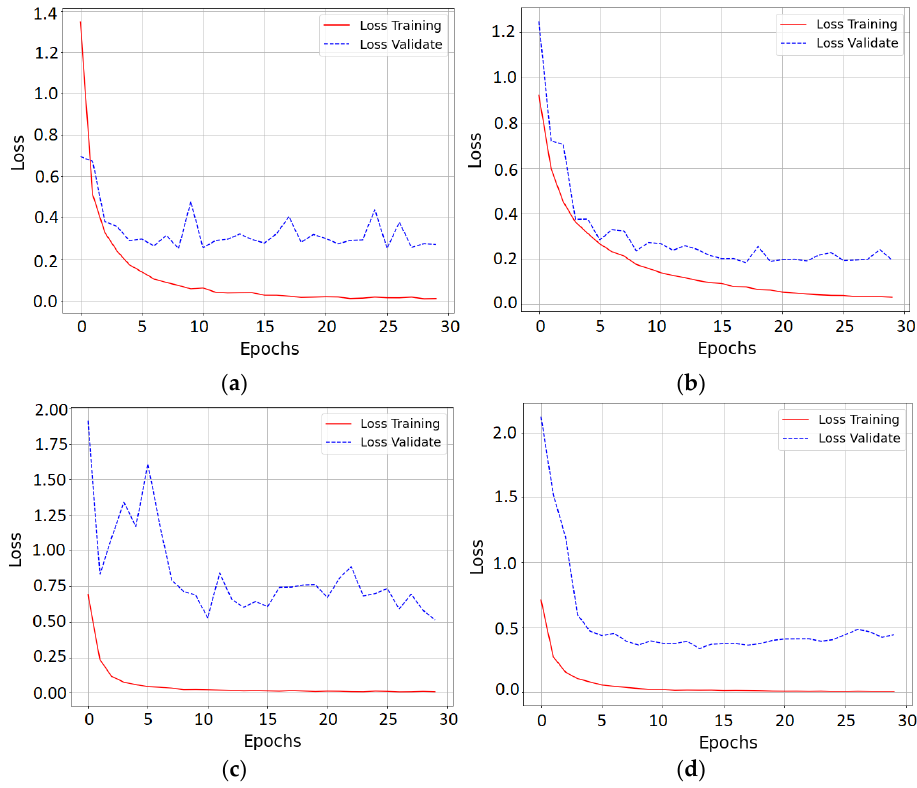
Figure 13. Training results for loss of the four best-performing models: ( a ) MobileNet, ( b ) SqueezeNet, ( c ) NasNetMobile, and ( d ) MobileNetV2. ( c ) NasNetMobile, and ( d ) MobileNetV2.